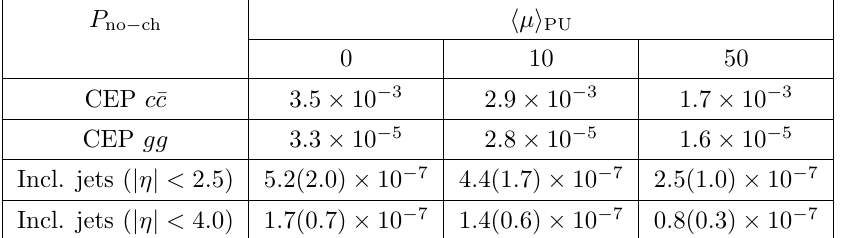
Table 7 . The no-charged rejection probabilities as a function of (cid:22) for c (cid:22) c and gg CEP, and inclusive ND jet production. The numbers in the (cid:12)rst column were obtained at particle level and then used to calculate the numbers in the other columns using eq. (5.1) and P z (cid:0) veto probabilities from table 1. The inclusive jet events were generated with Pythia 8.2 ( Herwig